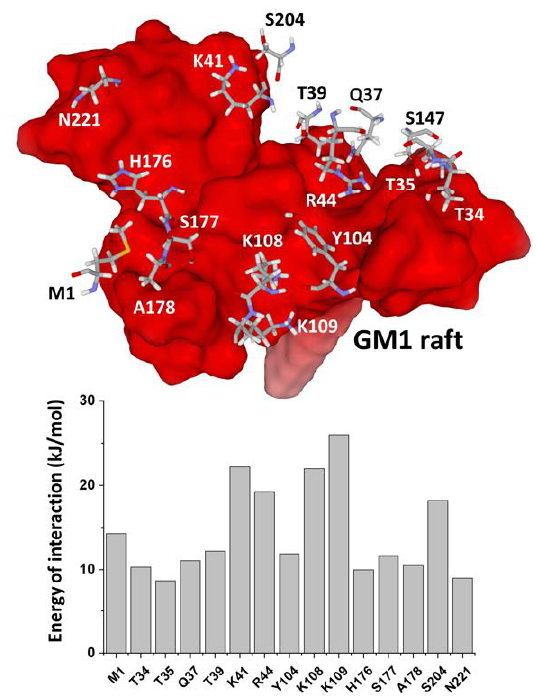
Figure 2. Molecular structure of the ganglioside-binding motif of the E8L protein. On the upper panel, the main amino acid residues involved in ganglioside binding (carbon in grey, oxygen in red, nitrogen in blue, hydrogen in white, sulfur in yellow) are represented over the GM1 cluster (electrostatic potential mostly negative represented in red). On the lower panel, the histograms show the contribution of each of these amino acids to the total energy of interaction (∆G in kJ.mol − 1 ) of the E8L-ganglioside complex.